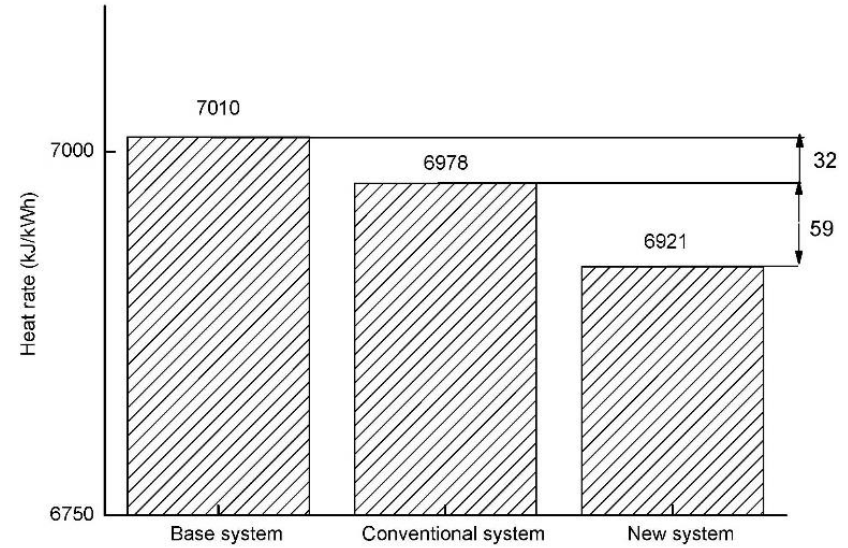
Figure 8. Comparison of heat rates.